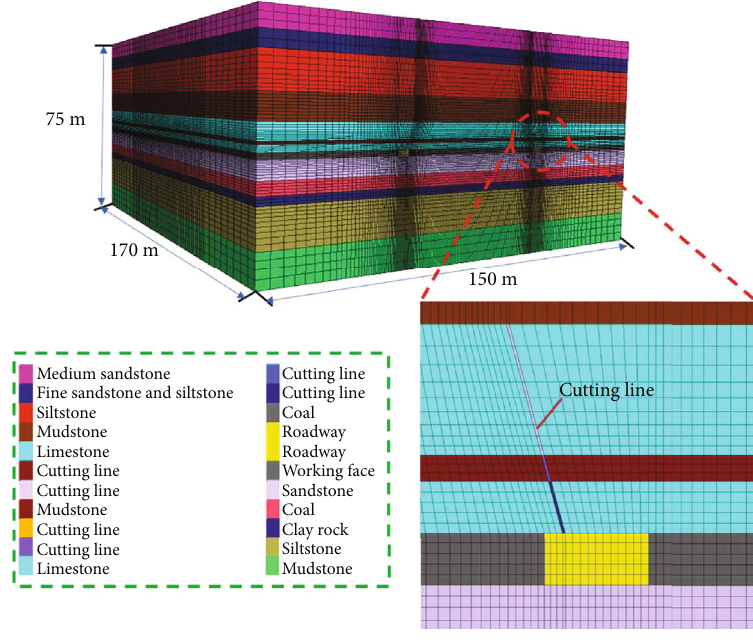
Figure 5: Numerical model.